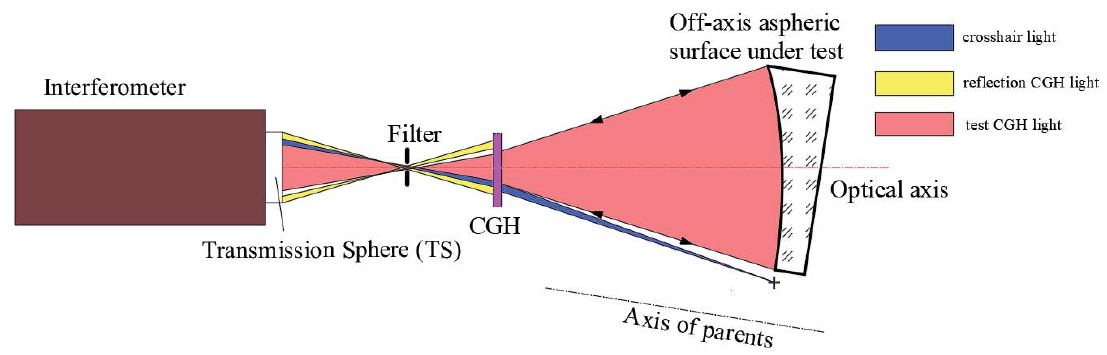
Figure 2. Schematic diagram of single computer generated hologram (CGH) method for o ff -axis aspheric